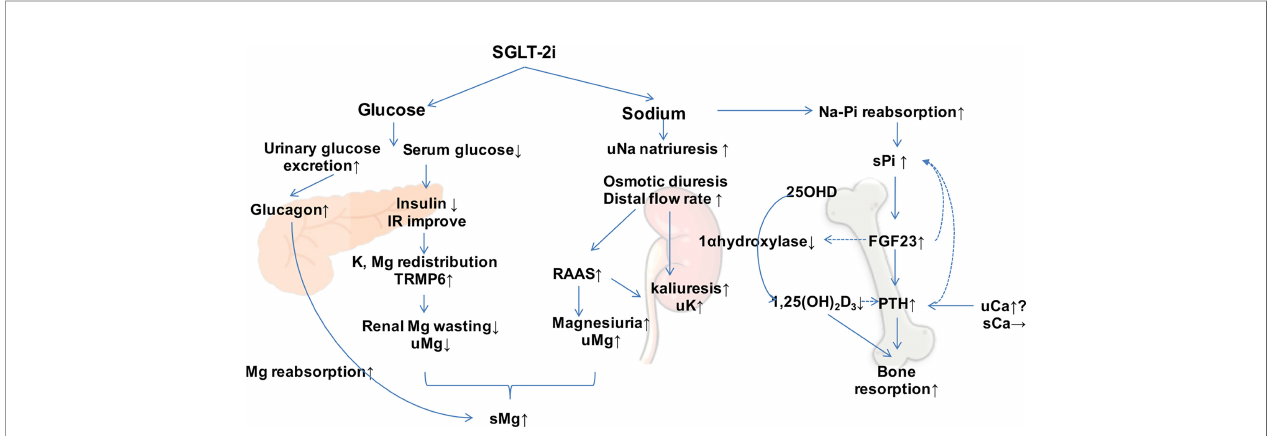
FIGURE 2 | Effect of sodium – glucose co-transporter 2 inhibitors (SGLT-2is) on mineral metabolism. SGLT-2is increase the excretion of urinary glucose and sodium and regulate minerals directly and indirectly. Dotted arrows show suppressive effects. s , serum; u , urinary; Mg , magnesium; Ca , calcium; Na , sodium; Pi , phosphorus; PTH , parathyroid hormone; FGF23 , fi broblast growth factor 23; IR , insulin resistance; RAAS , renin – angiotensin – aldosterone